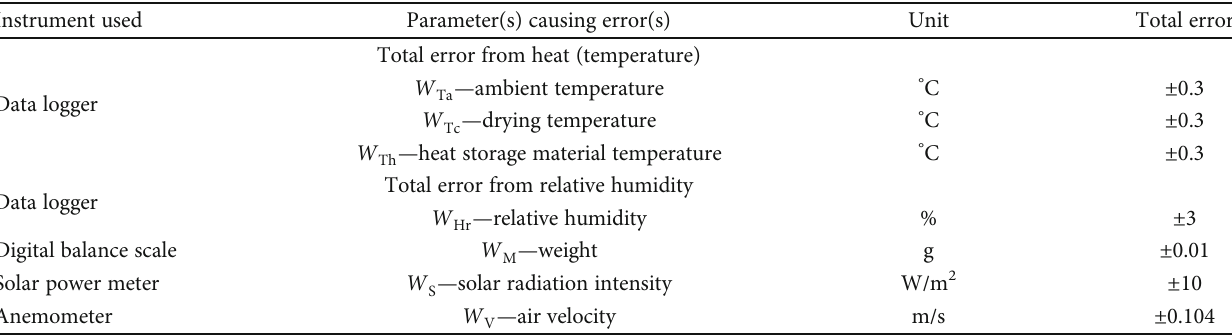
Table 2: Total values of errors made in drying